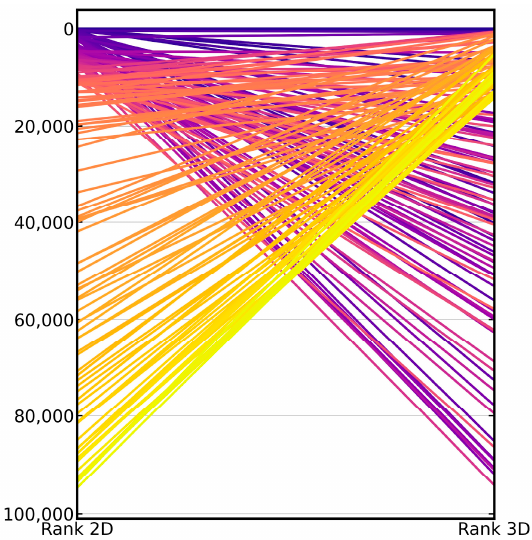
Figure 4. Parallel coordinate plot visualizing the differences in the ranks assigned to the known active compounds by the 2D approach (left) and the 3D approach (right). The plot shows the 100 top-ranked, active compounds reported by either method. From the plot, it is obvious that many of the active compounds that were rightly ranked at top positions by the 2D approach were missed by the 3D approach (in the top-ranked positions) and vice versa. The color spectrum applied to the lines visualizes the ranks assigned to the known active compounds by the 2D approach (dark blue: top ranks; yellow: lowest ranks). Table 4. Scaffold Recovery Rates for the Top 1% and Top 10% Ranks, averaged across the 50